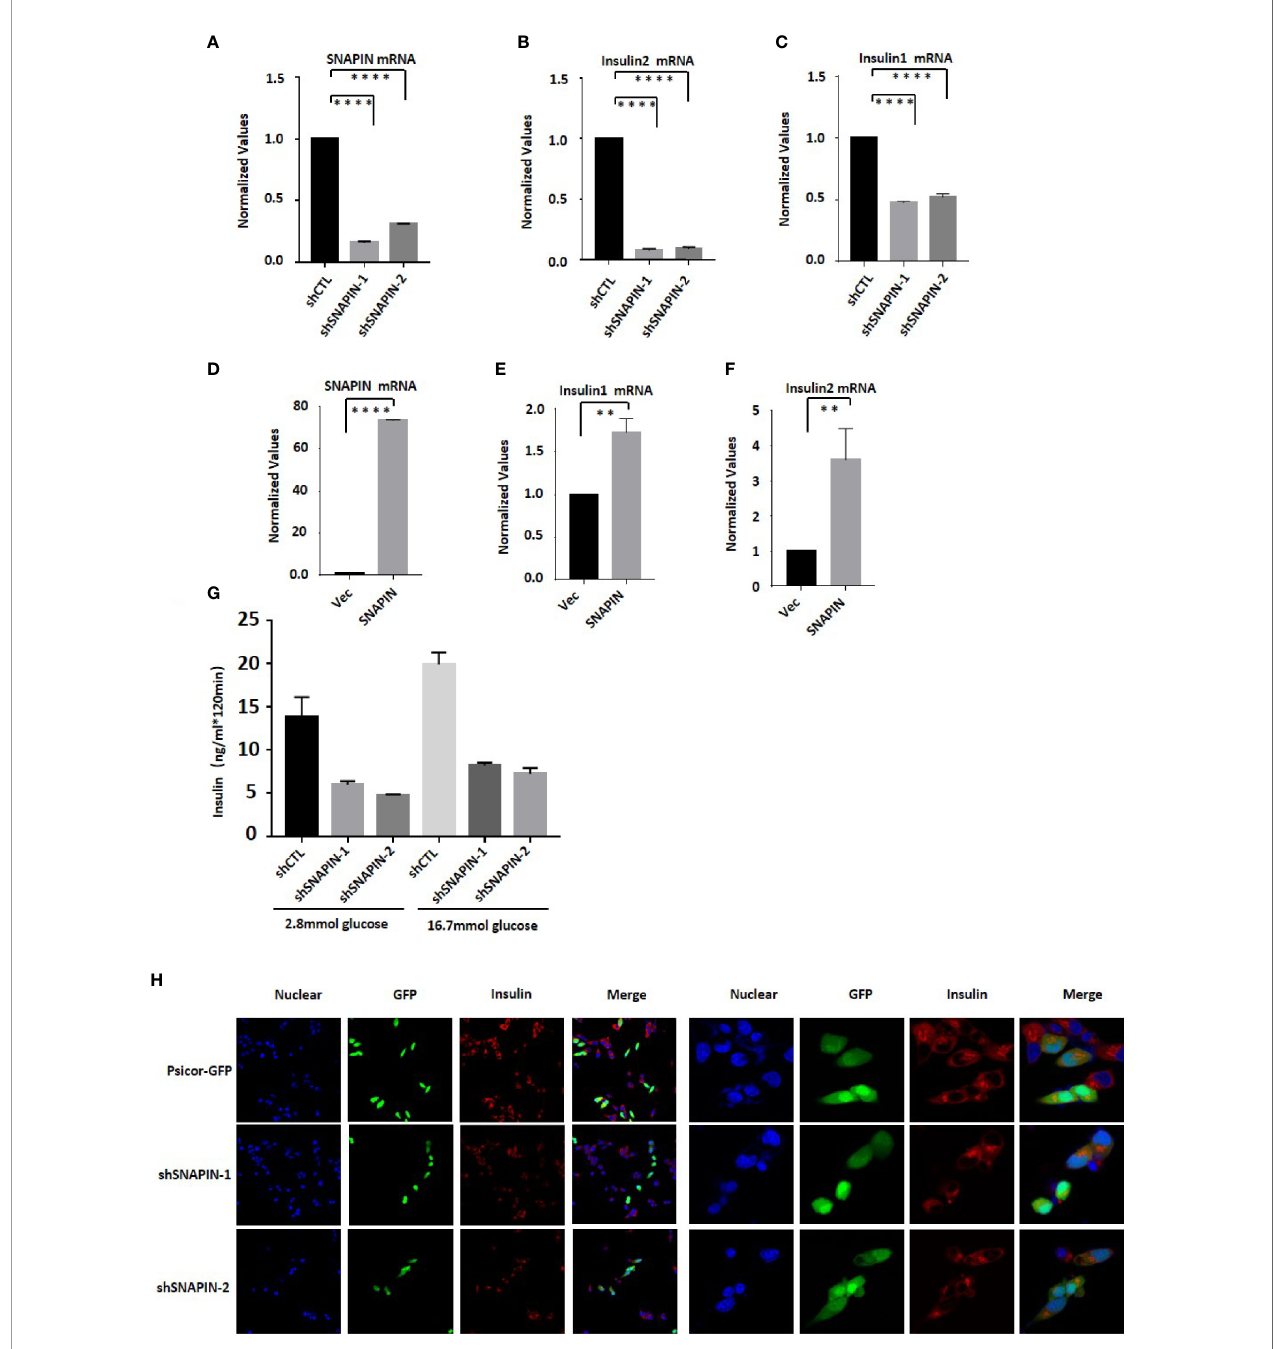
FIGURE 7 | SNAPIN affects insulin mRNA and protein levels. (A) SNAPIN knockdown ef fi ciency in b cells. (B, C) SNAPIN knockdown inhibit Insulin mRNA expression in b cells. (D) SNAPIN overexpression ef fi ciency in b cells. (E, F) SNAPIN overexpression increased Insulin mRNA expression in b cells. QPCR was performed to measure the mRNA expression of insulin. Data are shown as the mean ± SD, n = 3. (G) SNAPIN knockdown inhibits insulin protein expression in INS1 cells. Glucose-induced insulin secretion measured by ELISA. (H) SNAPIN knockdown inhibits insulin protein expression in Min6 cells. INS1 cells were transduced with lentivirus expressing shRNA which obtained GFP. The vector was Psicor-GFP. The insulin protein expression levels were measured by immuno fl uorescence. The nuclei were labeled with DAPI (blue) (4 ʹ ,6-diamidino-2-phenylindole), insulin protein was labeled with the Alesa Fluor 643 (red) and shSNAPIN was labeled with the GFP (yellowish-green). **P < 0.01, ****P <